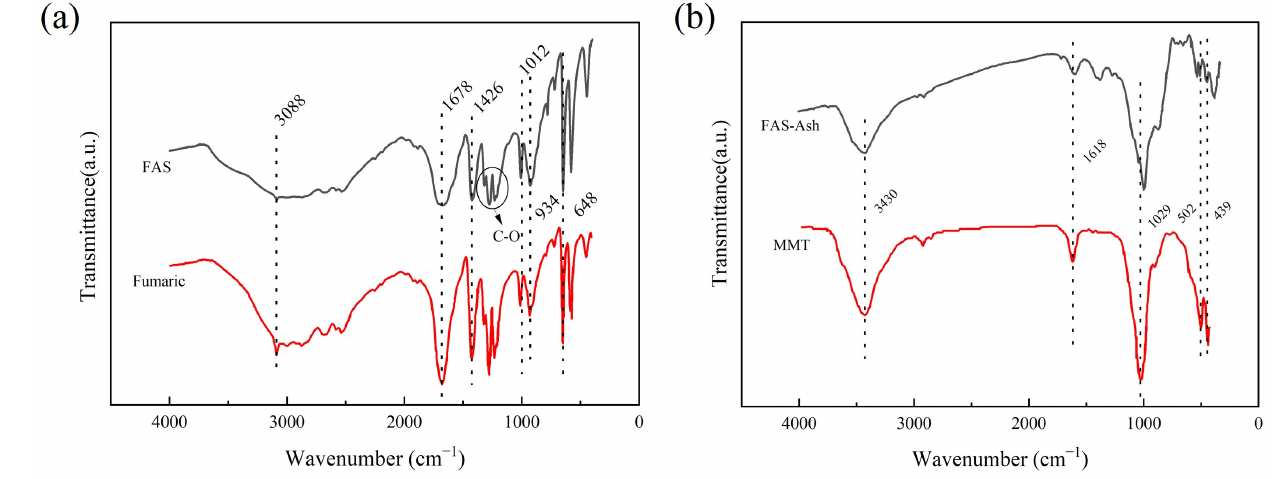
Figure 2. FT-IR spectrum comparison: ( a ) FAS and Fumaric; ( b ) FAS-Ash and